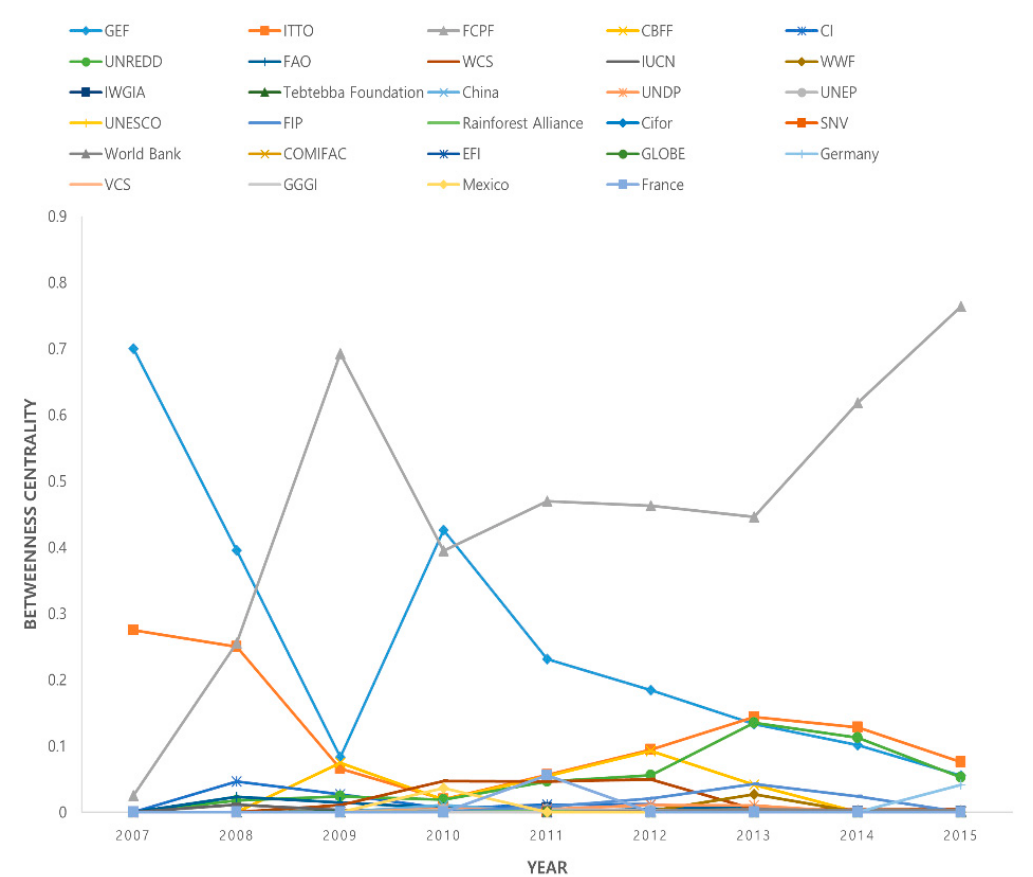
Figure 10. Annual changes in betweenness centrality from 2007 to 2015. (IWGIA: International Work Group for Indigenous Affairs, UNDP: United Nations Development Programme, UNEP: United Nations Environment Programme, FIP: Forest Investment Program, EFI: European Forest Institute, GLOBE: Global Legislators for a Balanced Environment, VCS: Verified Carbon Standard, GGGI: Global Green Growth International).